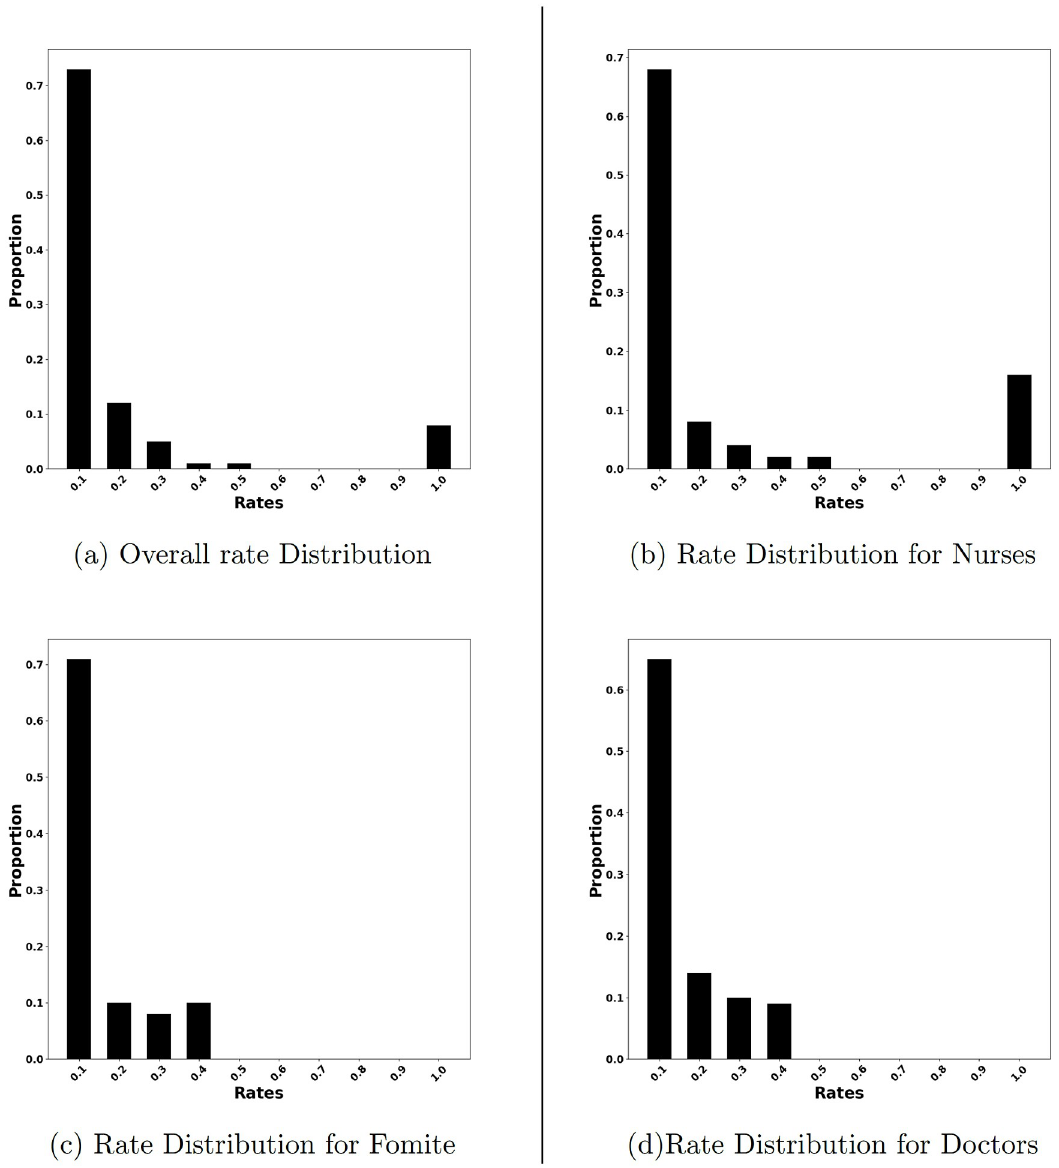
Fig 12. Distribution of allocation for different rates. Since most of the sensors selected by H AI D ETECT have low rates, they have to be monitored only sporadically.